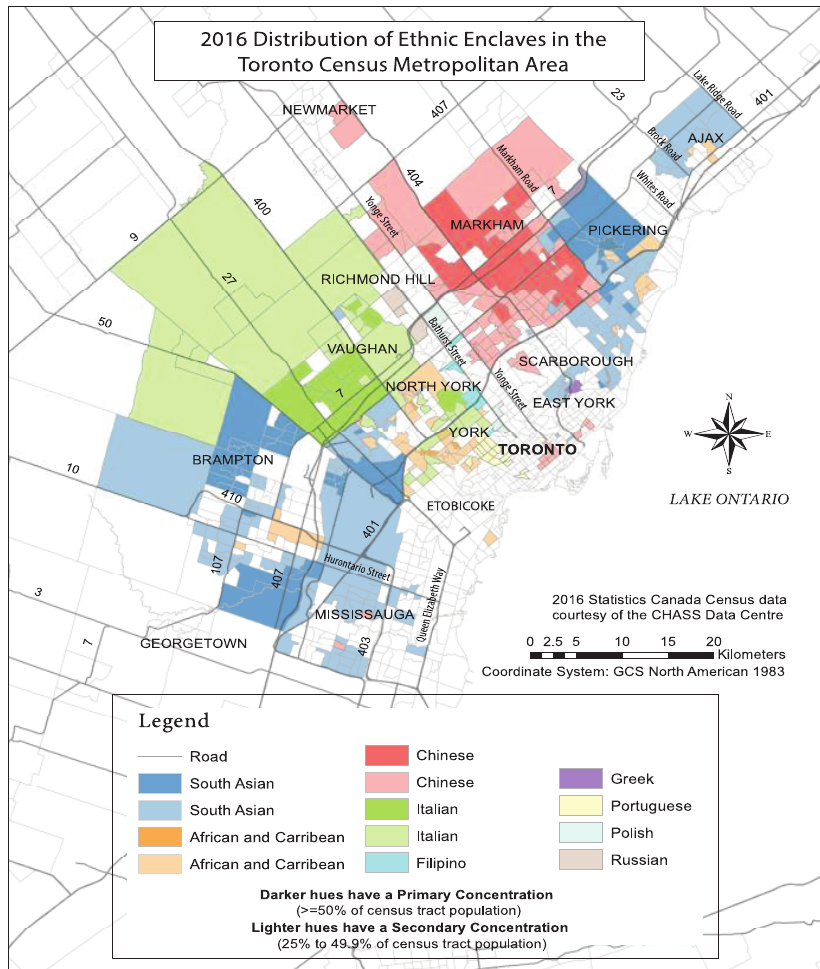
Figure 1. Primary and secondary ethnic enclaves in the GTA (Qadeer & Agrawal,